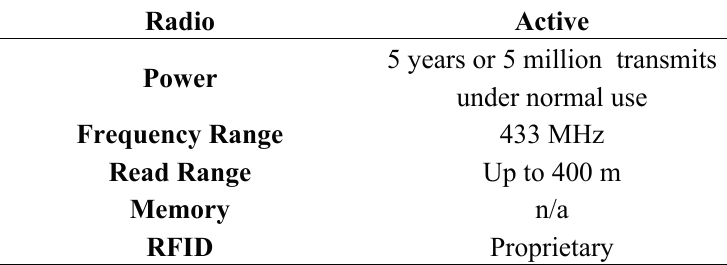
Table 1. The specifications of the RFID tag used in this